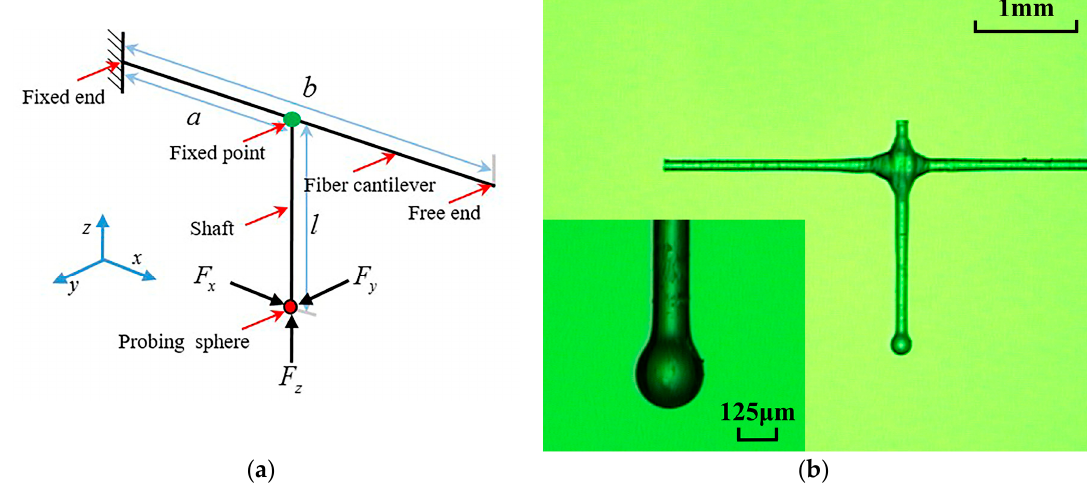
Figure 2. Structure of the probe: ( a ) structure diagram of the ACF probe; and ( b ) photograph of the ACF probe.